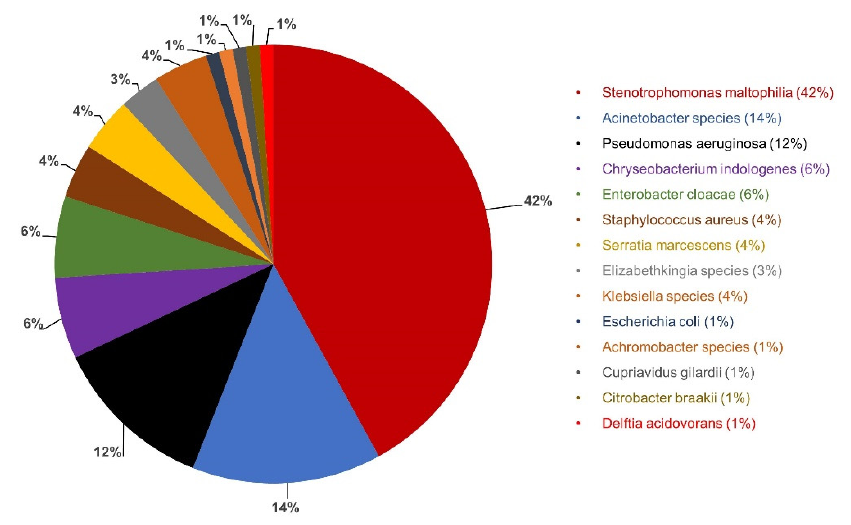
Figure A1. Pathogens isolated from respiratory specimens.